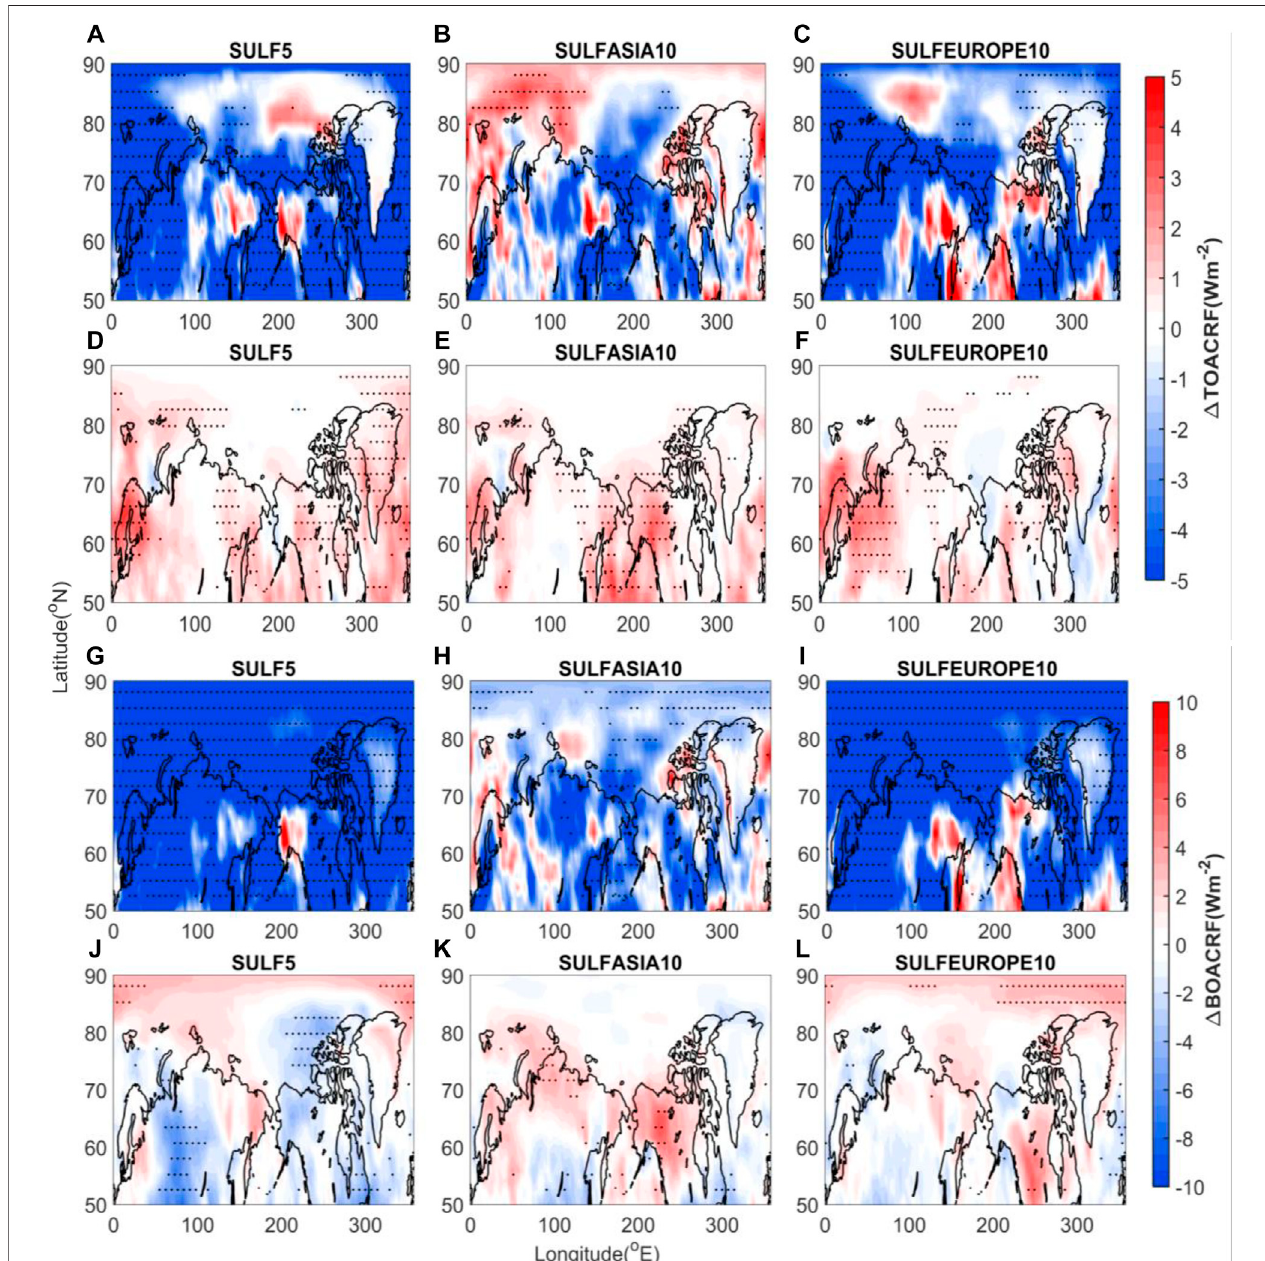
FIGURE 6 | Cloud radiative forcing anomalies (EXPT-CTRL) at top of the atmosphere for (A – C) summer season and (D – F) winter, (G – I) same as (A – C) but for the bottom oftheatmosphere, (J – L) same as (D – F) butfor thewinterseason.Stippling indicates statisticalsigni fi canceat 90%con fi dence leveldeterminedusing student ’ s t-test for the difference of the